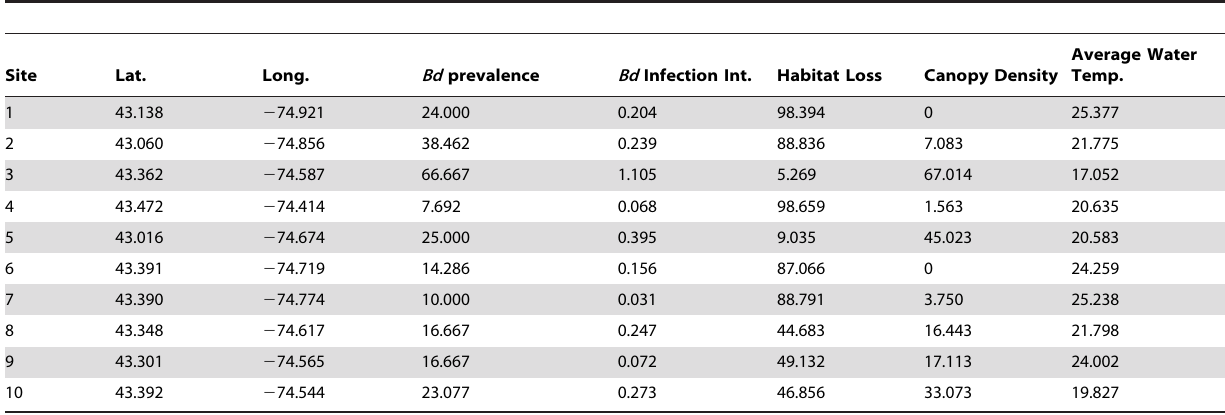
Table 2. Best explanatory variables predicting Bd prevalence (%) and infection intensity (average g.e. log) across ten sites in the southern Adirondack region, New York, USA [Habitat loss (%), canopy density (%), and average water temperature ( u C)].